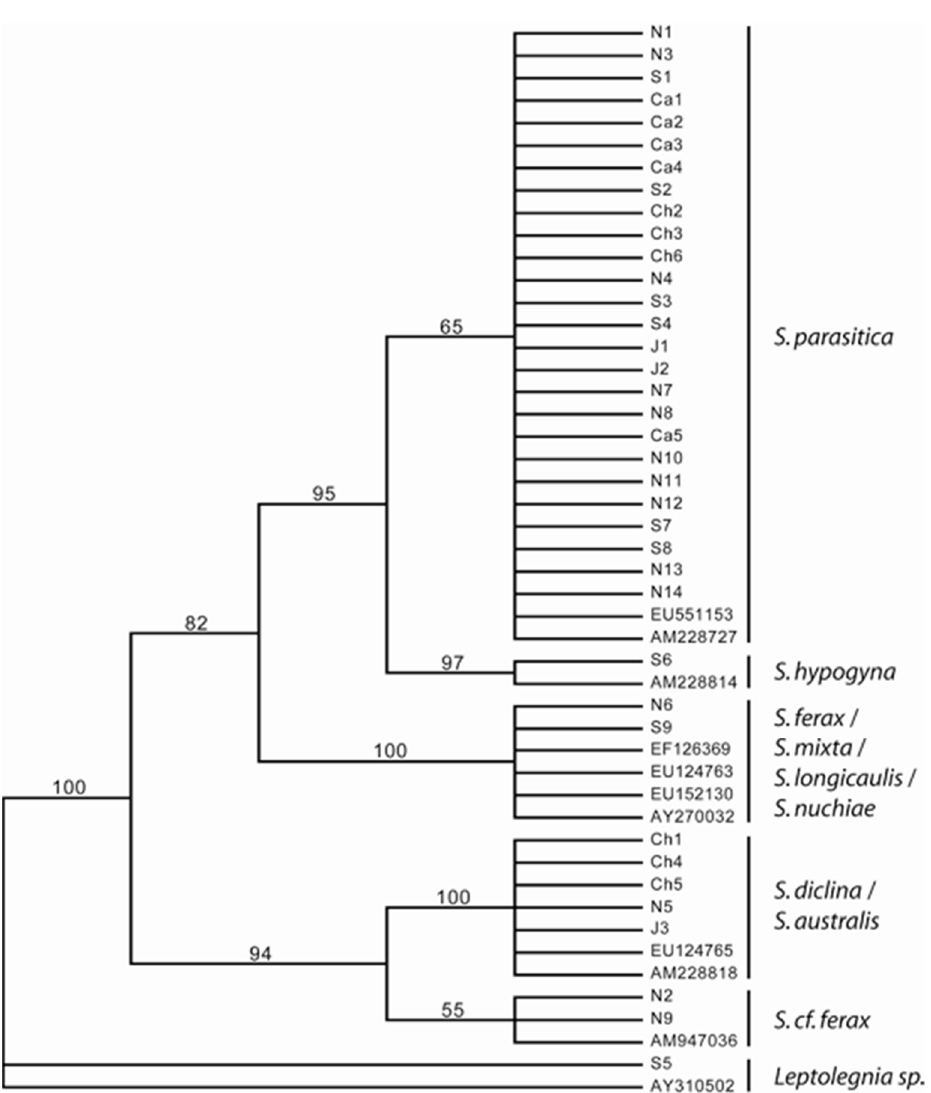
Figure 3. Phylogram of isolates of Saprolegnia spp. as revealed by sequencing of ITS region 2. The isolates are described by their geographic origin, their ability to produce long spines on cysts and their pathogenicity to salmon (Table 1).